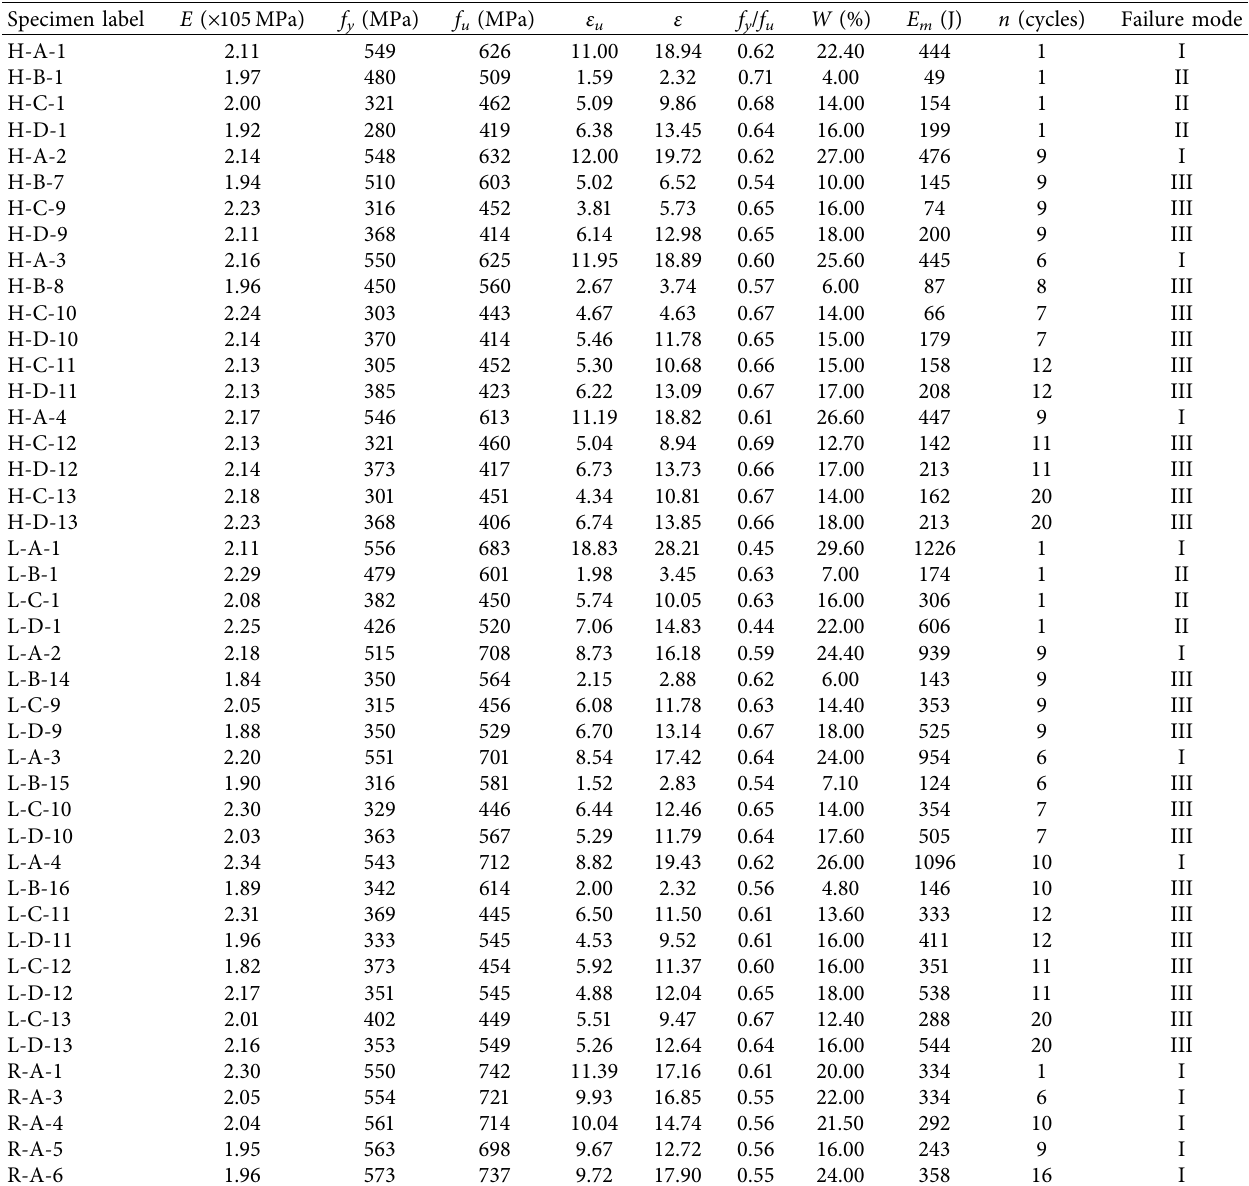
Table 5: Summary of test